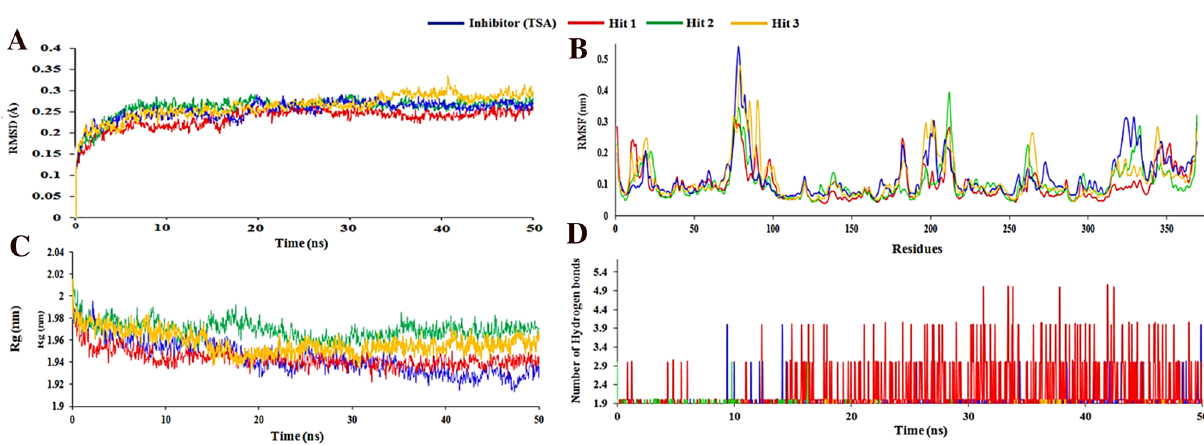
Figure 8. RMSD plots for checking the overall stability of the systems during 50 ns MD simulations; ( A ) RMSD profile of HDAC3 in presence of hit compounds, ( B ) RMSF of simulated complexes of HDAC3 with hit compounds, ( C ) Radius of gyration of HDAC3 with bound hit compounds and ( D ) Time dependent hydrogen bonds between HDAC3 and hit compounds. The figure is drawn using Microsoft Excel 2013